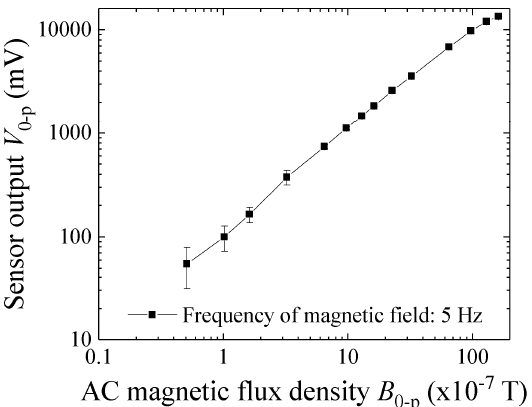
Figure 12. Variation of the sensor output as a function of magnetic flux density (from [1]).